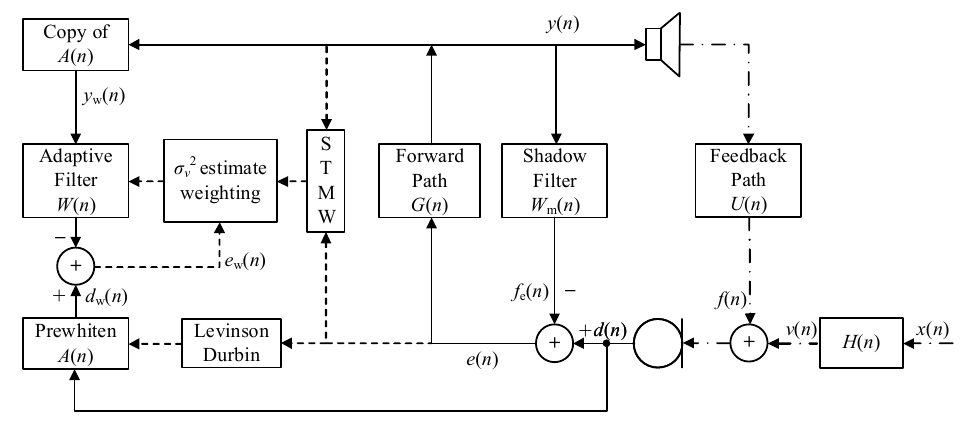
Figure 2. Schematic diagram of PEM-WNPVSS.